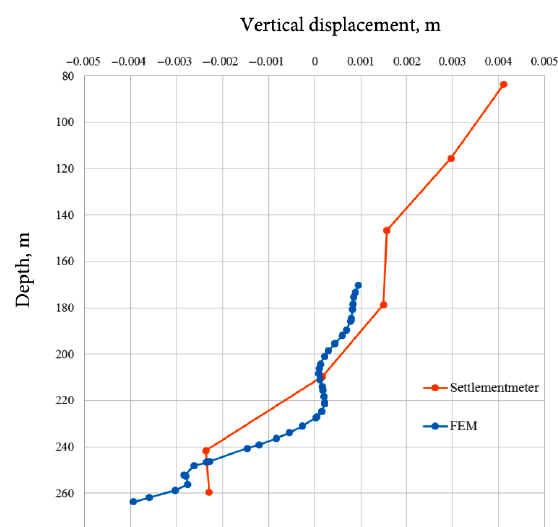
Fig. 11. Evaluation of vertical displacements of modeling and instrumentations versus